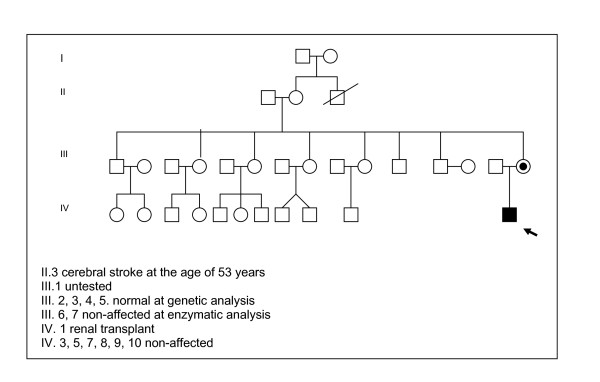
Family pedigree.